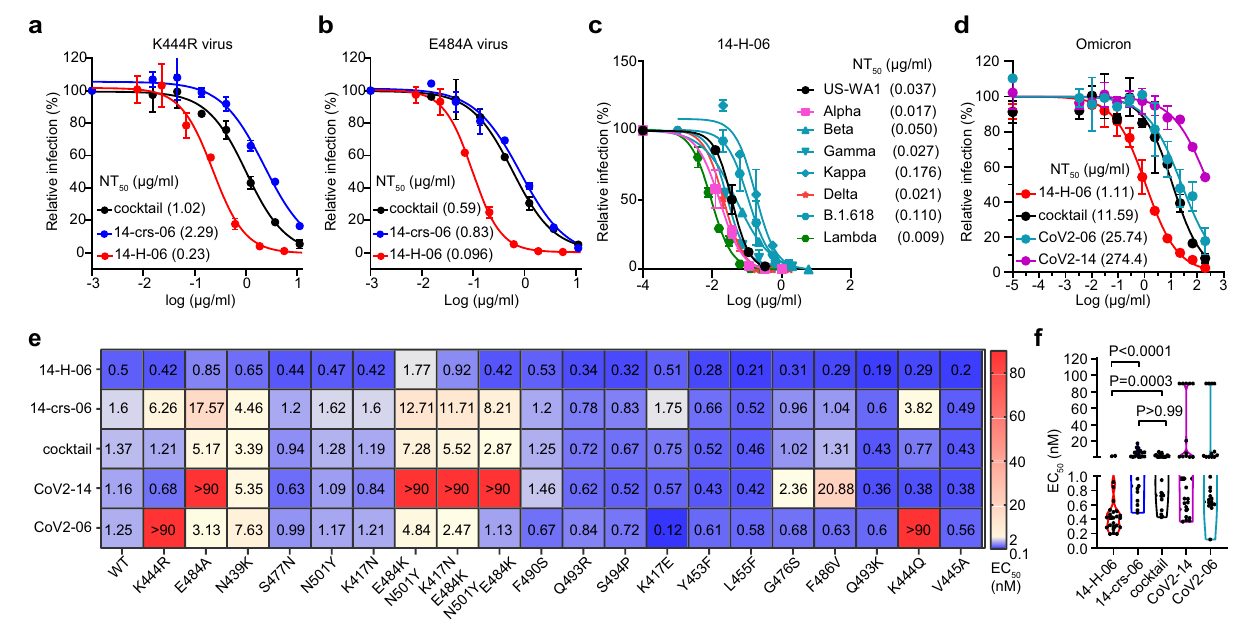
Fig. 4 | Broad coverage of variants by 14-H-06. a , b Neutralizations of the CoV2- 06-resistant SARS-CoV-2 virus with K444R mutation ( a ) and CoV2-14-resistant SARS-CoV-2 virus with E484A mutation ( b ) by indicated bispeci fi c antibodies and the antibody cocktail of CoV2-06 and CoV2-14. The assay is based on the mNeon- Green reporter virus and the NT 50 values are labeled. c Plaque reduction neu- tralization test (PRNT) of 14-H-06 against the SARS-CoV-2 US-WA1 strain and recombinant SARS-CoV-2 viruses with the spike replaced by those from indicated